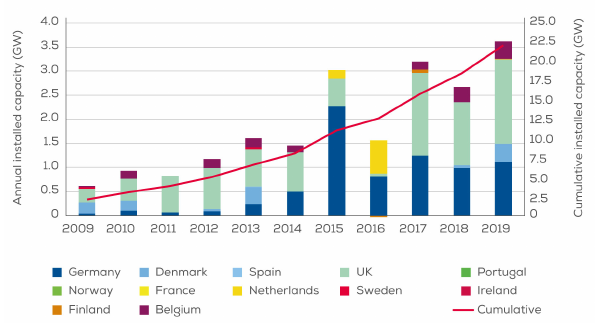
Figure 1. European offshore wind installed and cumulative capacity